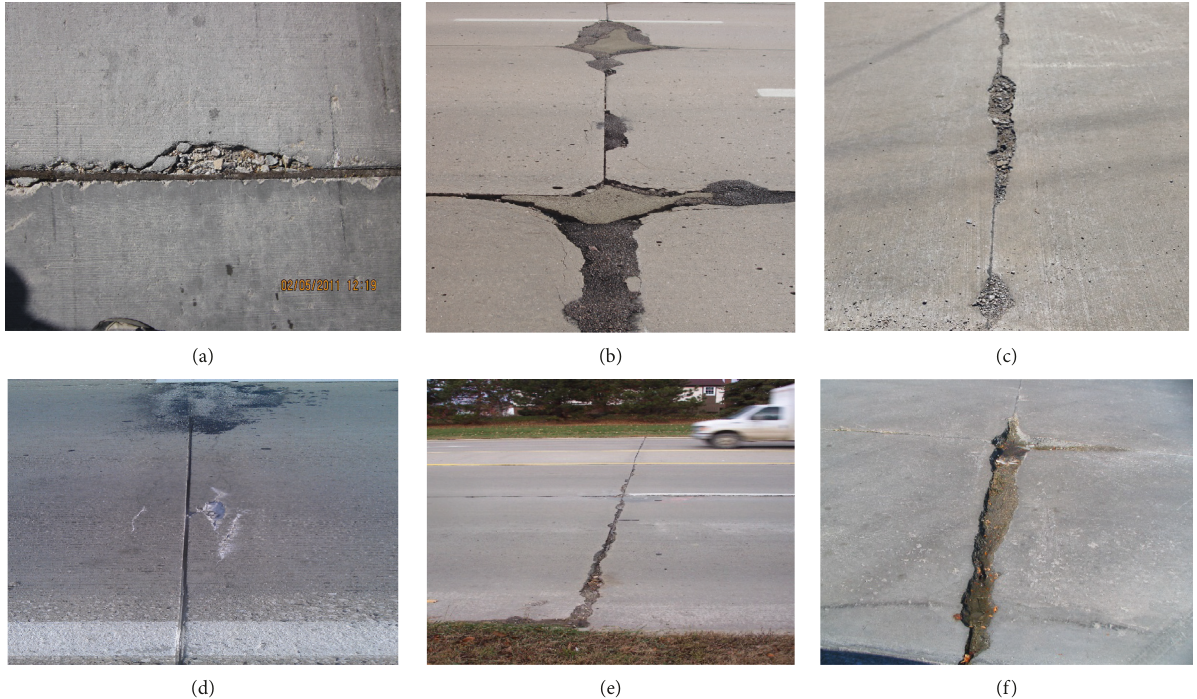
Figure 1: Photos of joint deterioration from multiple states. (a) Arizona, 2011. (b) Colorado, 2010. (c) Illinois, 2014. (d) Kansas, 2012. (e) Missouri, 2005. (f) Nebraska,